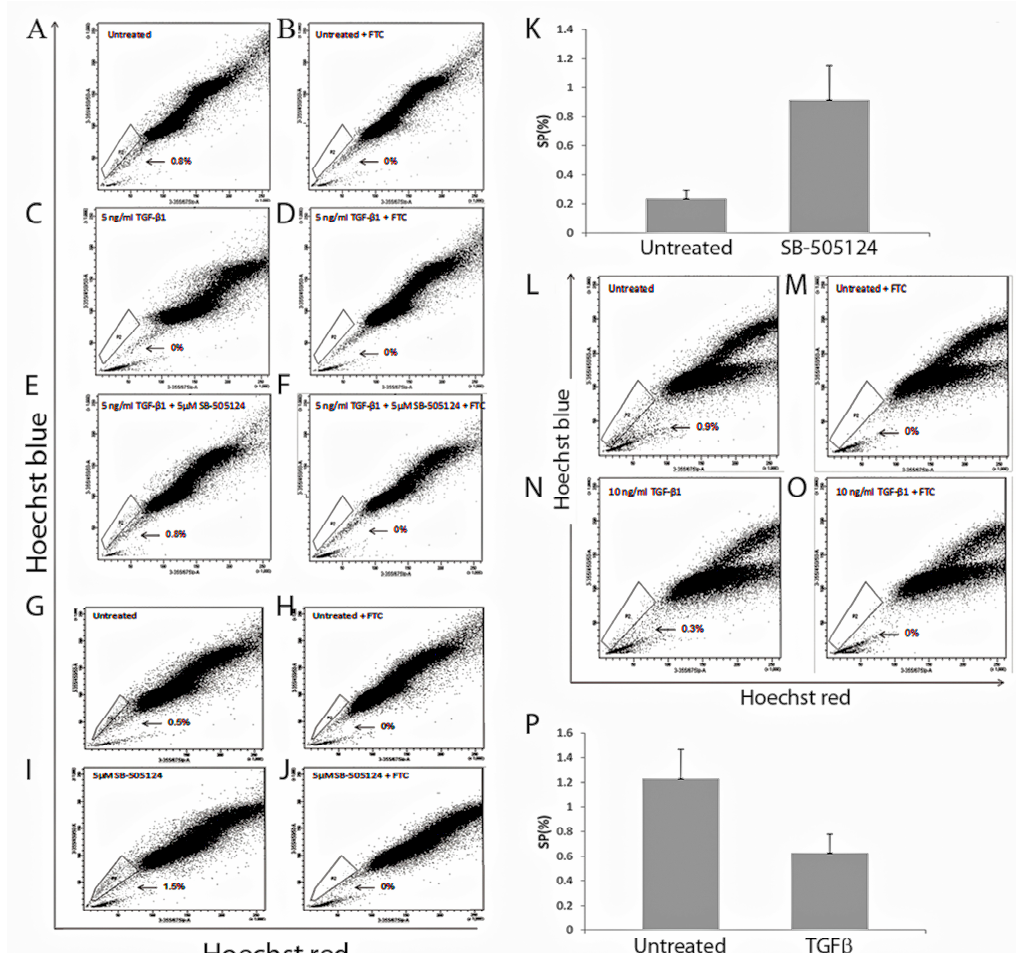
Figure 4. Impact of TGF- β 1 treatment on SP cells of the MDA-MB-231 and MCF7 cell lines. Representative FACS images of SP analysis in MDA-MB-231 cells. ( A ) Untreated ( C ) Treated with 5 ng/mL TGF- β 1 ( E ) Treated with 5 ng/mL TGF- β 1 and 5 µ M SB-505124. FTC, was used to confirm the SP phenotype in ( B , D , F ). Representative FACS images of SP cells from the same culture ( G ) 0.5% SP percentage in untreated cells, while in the presence of 5 µ M SB-505124 only, this percentage increased to 1.5% ( I ). For both untreated and treated cells FTC was used as a control to confirm the SP phenotype ( H , J ). The SP percentage for both untreated and SB-505124 treated MDA-MB-231 are represented graphically in ( K ). Bars represent an average of n = 6 individual experiments, note the increase in SP percentage in the presence of SB-505124, p = 0.03. Representative FACS images of SP analysis in MCF7 cells ( L ) Untreated, ( N ) Treated with 10 ng/mL TGF- β 1. FTC was used to confirm the SP phenotype in ( M , O ). The SP percentages for both untreated and TGF β treated MCF7 are graphical represented ( P ). Bars represent n = 7 individual experiments, note the significant increase in MCF7 SP in the untreated group compared to the cells treated with TGF- β 1, p = 0.03. Bulk MCF7 cells were treated with 10 ng/mL TGF- β 1, (use of 5 ng/mL did not effectively eliminate the SP population) for 3 days and SP analysis was performed.